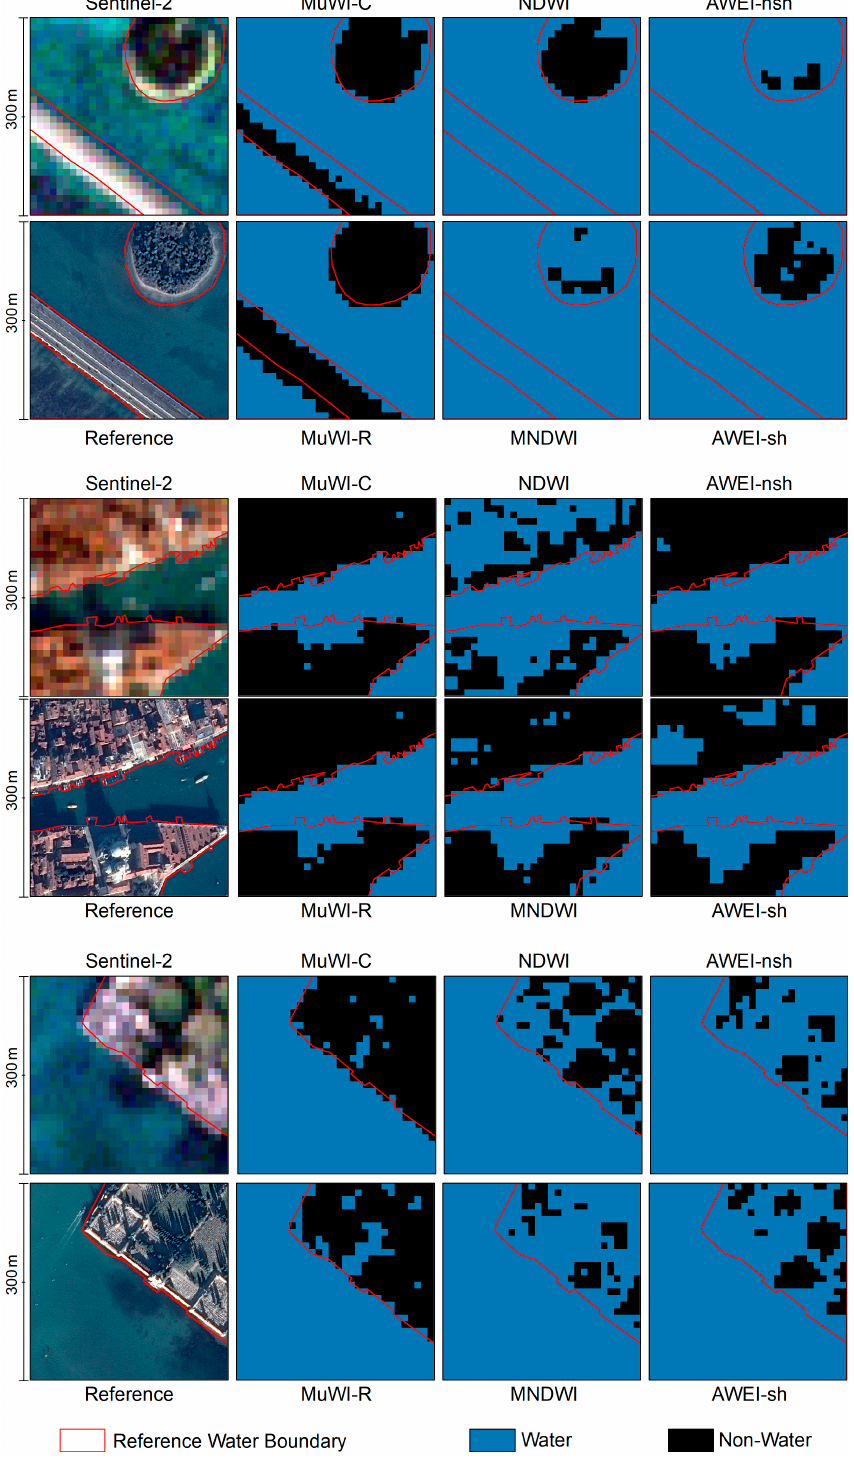
Figure 5. Three reference sites that are profoundly impacted by low-albedo confusions from asphalt ( top ), built-up shadow ( middle ) and vegetation shadow ( bottom ). The first column shows 10-m Sentinel-2 RGB image and 0.5-m reference RGB image. Column 2, 3, and 4 shows the water mapping results by six water index (MuWI-C, MuWI-R, NDWI, MNDWI, AWEI-nsh, AWEI-sh).